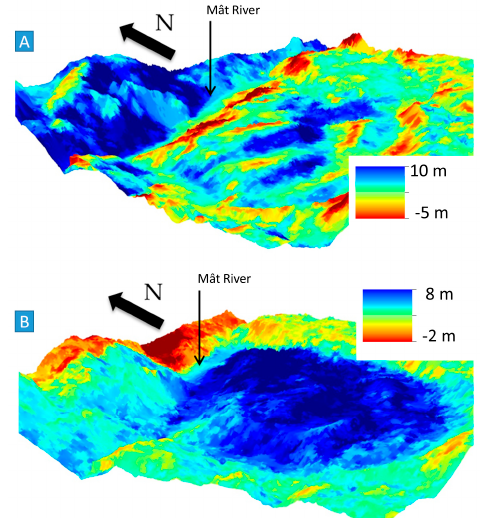
Figure 5. ( A ) East-west shift measured by MicMac and draped on the topography of the study area. Positive values toward the east. A strong correlation appears between the slope aspect and the shift for the 2006–2008 period; ( B ) South-north shift measured by MicMac and draped on the topography of the area. Positive values toward the north. The landslide is clearly visible with a strong shift toward the north for the 2006–2008 period.